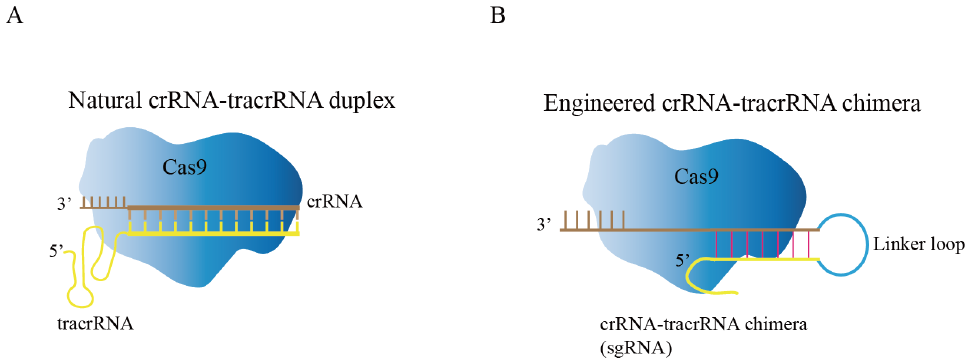
Figure 2. Composition of CRISPR/Cas9 genome editing system. ( A ) Natural CRISPR/Cas9 genome editing system, crRNA and tracrRNA form guide RNA (gRNA) through local base pairing. ( B ) Engineered CRISPR/Cas9 genome editing system; the crRNA-tracrRNA chimera was modified to form sgRNA by creating a connecting loop.